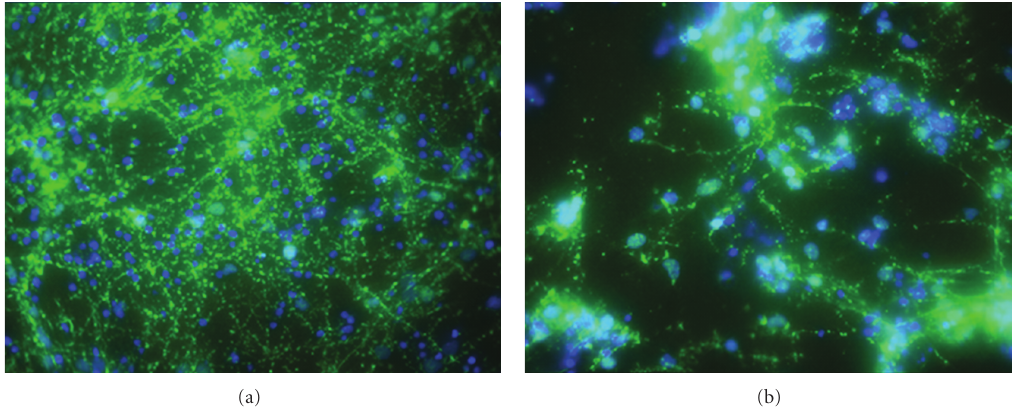
Figure 3: Nitric oxide promotes axonal injury to cerebellar neurones in vitro. Immunofluorescent images depicting cerebellar axonal morphology (a) pre- and (b) posttreatment with 0.1mM NO. Green: axonal marker SMI 312. Blue: DAPI nuclear